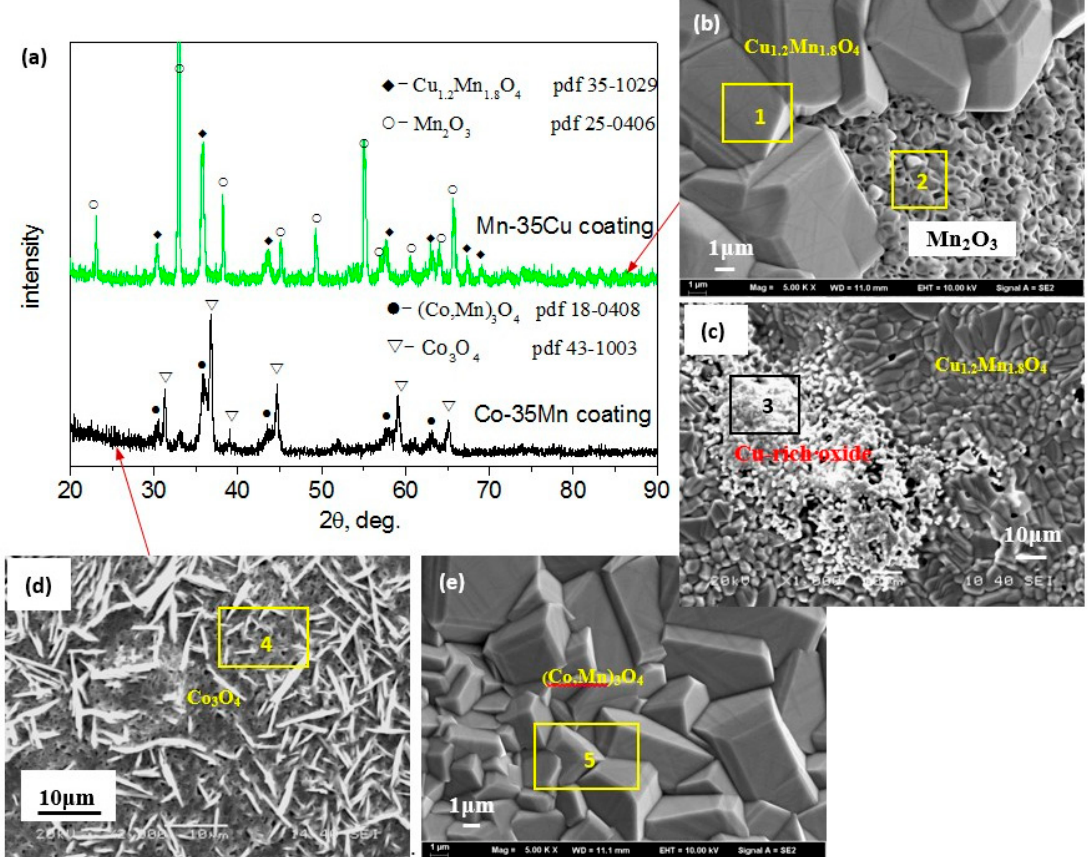
Figure 3. ( a ) X-ray diffraction of Mn-35Cu and Co-35Mn coatings oxidized at 750 °C in air for 100 h, ( b , c ) surface morphology of Mn-35Cu coating oxidized at 750 °C in air for 100 h, ( d , e ) surface morphology of Co-35Mn coating oxidized at 750 °C in air for 100 h. Table 1. Composition analysis of local areas in Figure 3 by energy dispersive X-ray spectroscopy (EDS). Elements, at.